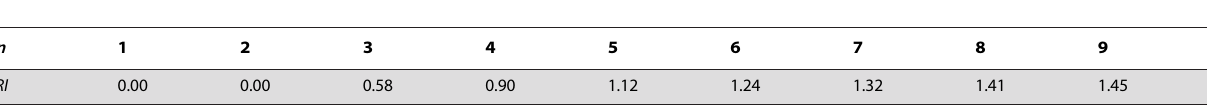
Table 2. Random consistency index for AHP.